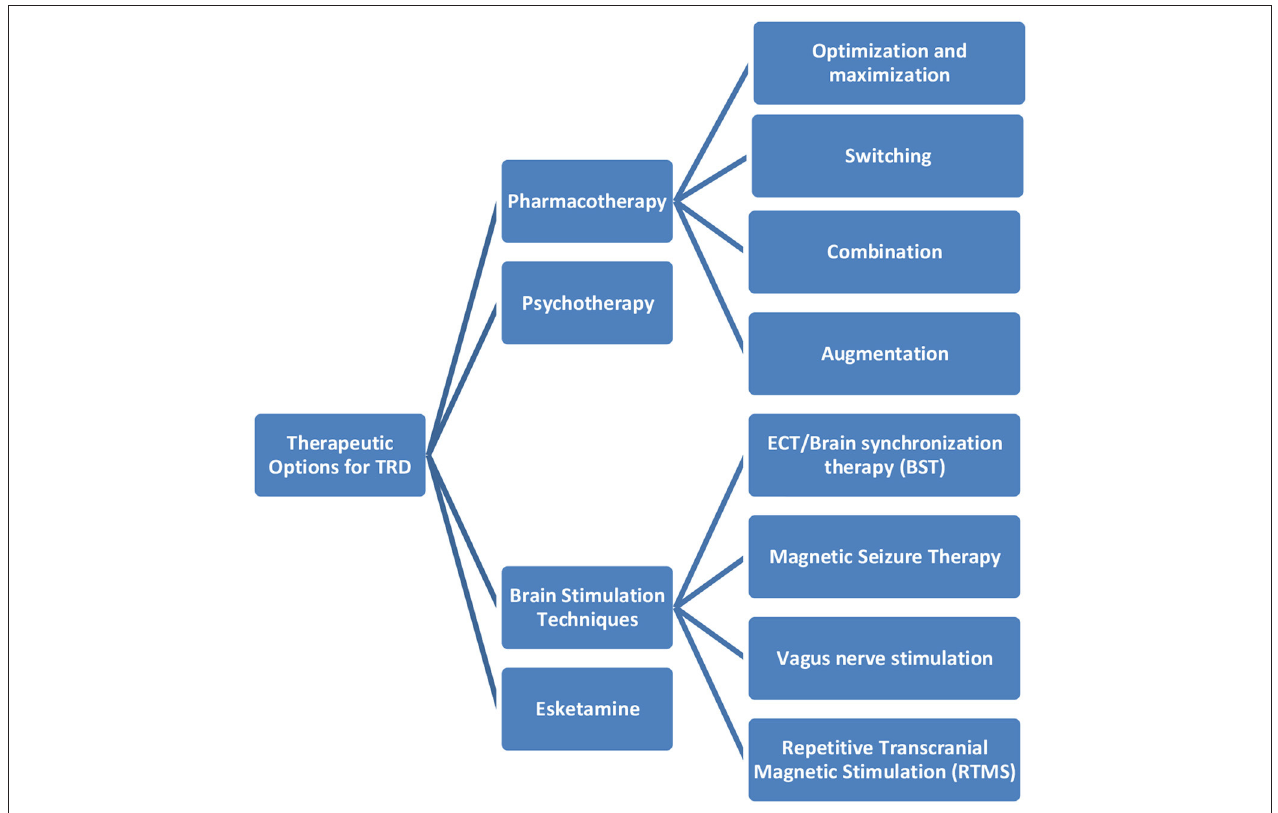
FIGURE 1 | The available therapeutic options for